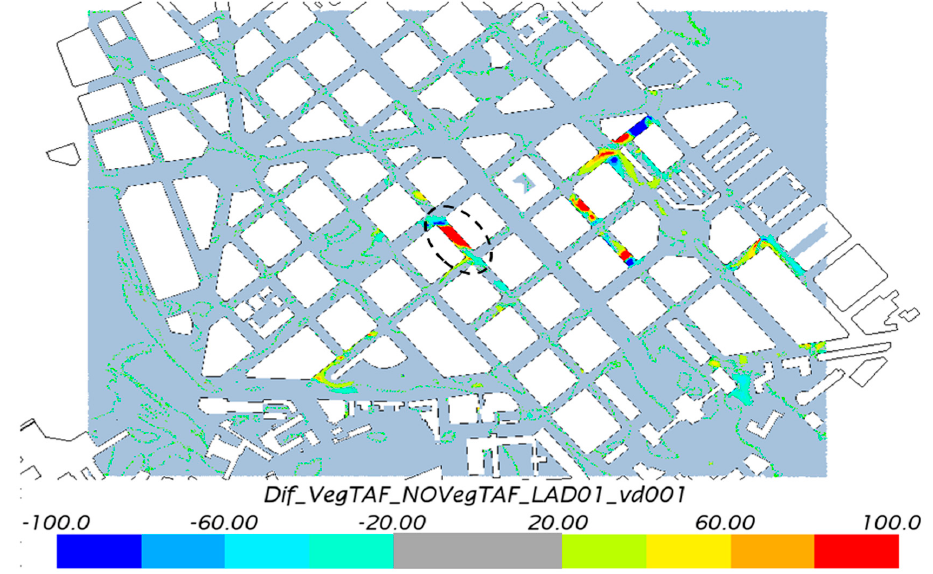
Figure 10. Differences of concentration comparing Current-1c case with New-1c case. Red indicates that the concentration increases in the new vegetation scenario and grey indicates the zone where the differences are lower than 20 µg m − 3 .